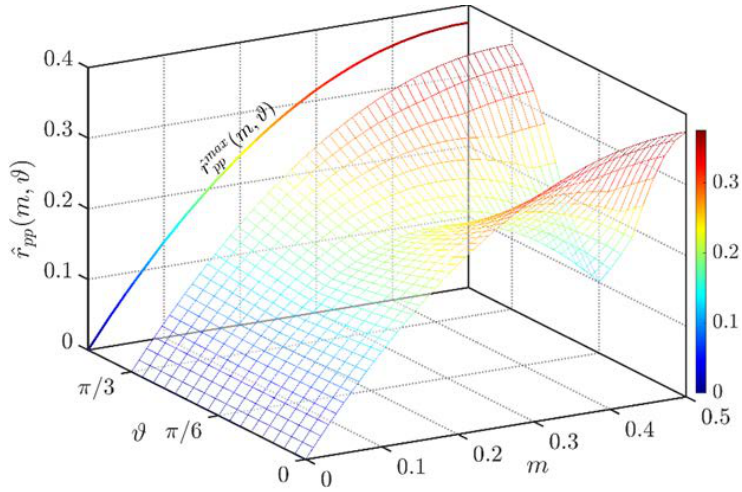
Figure 6. Normalized capacitors switching voltage ripple (ˆ r 1 and ˆ r 2 ) (blue traces), dc-link switching voltage ripple (ˆ r ) (red trace) and calculated envelopes (black traces) over a fundamental period for m = 0.4 ( a ) and m = 0.5 ( b ) in case of ϕ = 0 ◦ and balanced load.